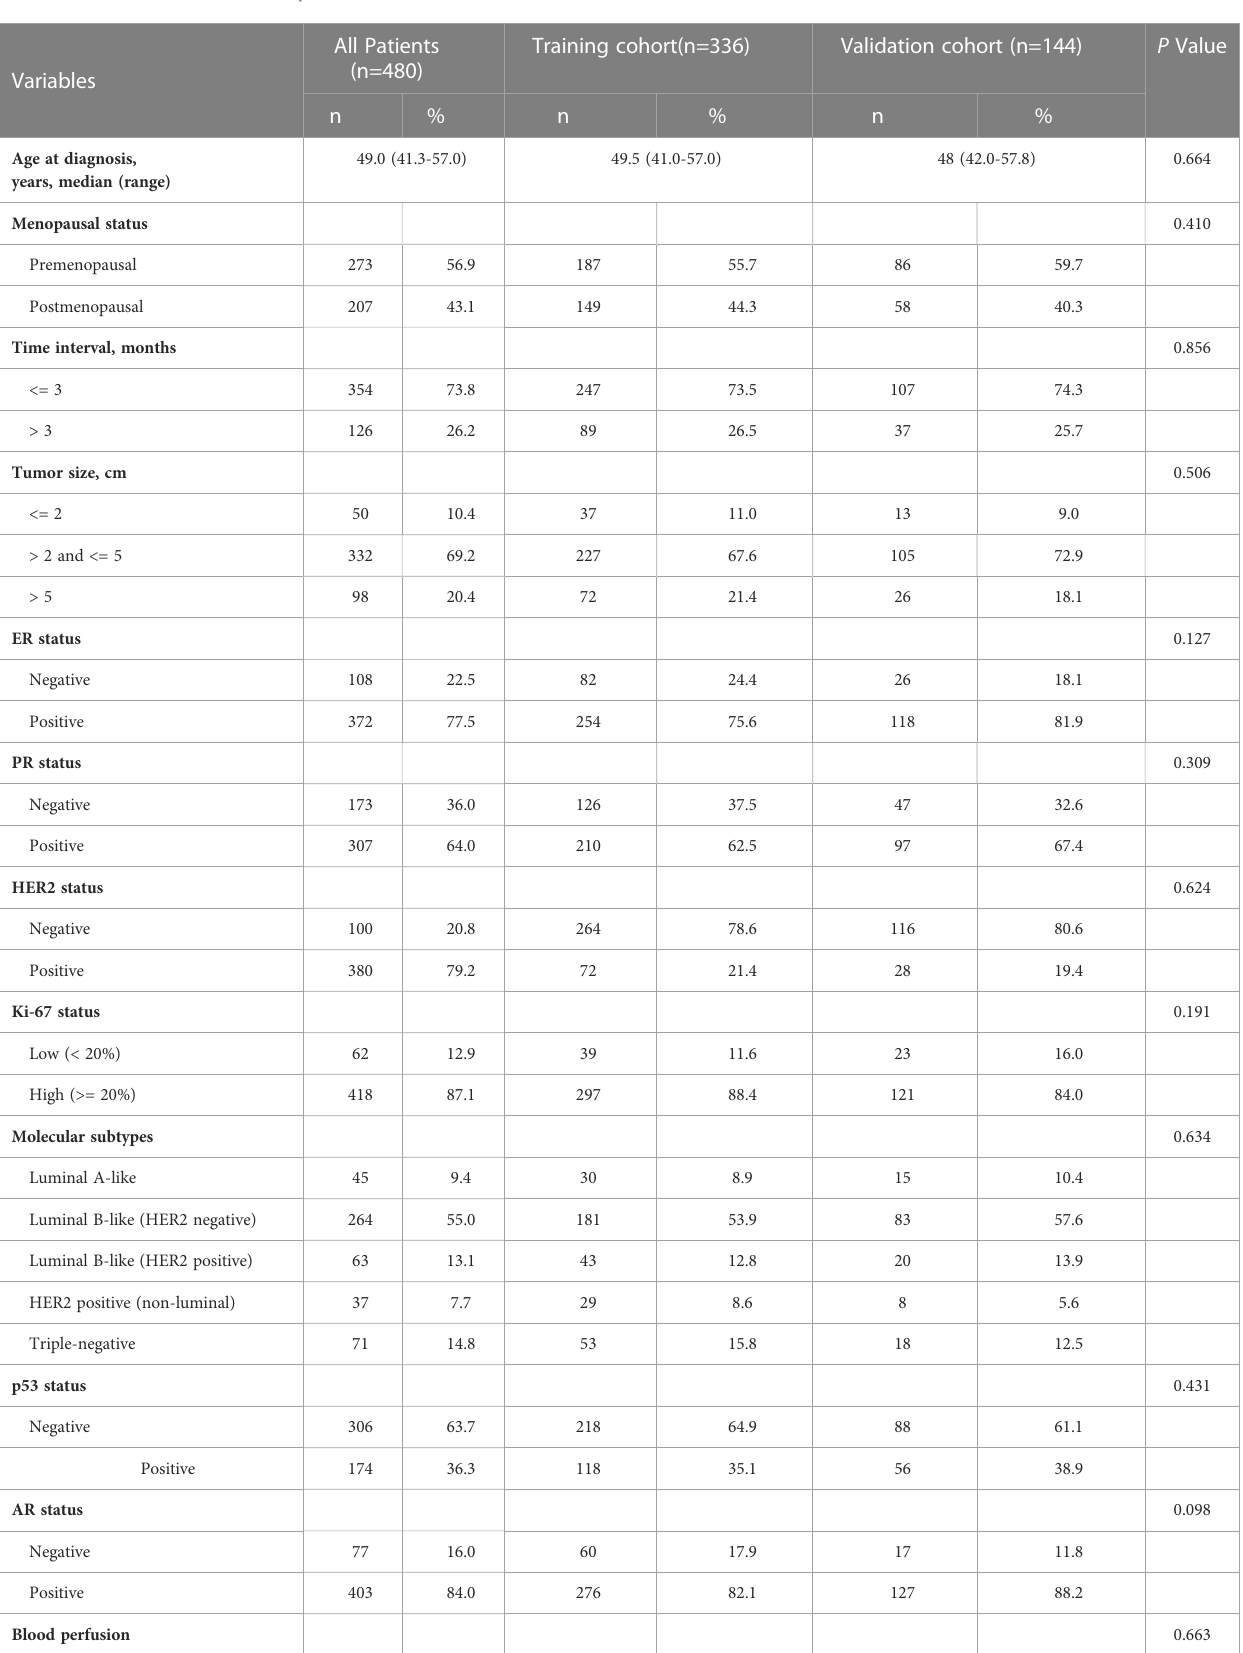
TABLE 1 Baseline characteristics of patients with invasive breast